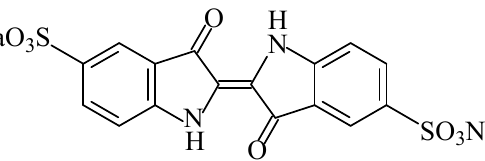
Figure 24. Structural formula of indigotine, or carmine-de-indigo (E132).